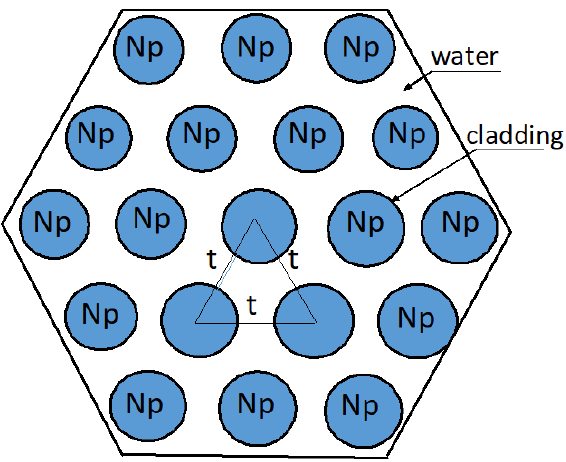
Figure 6. FA with NpO 2 -rods.